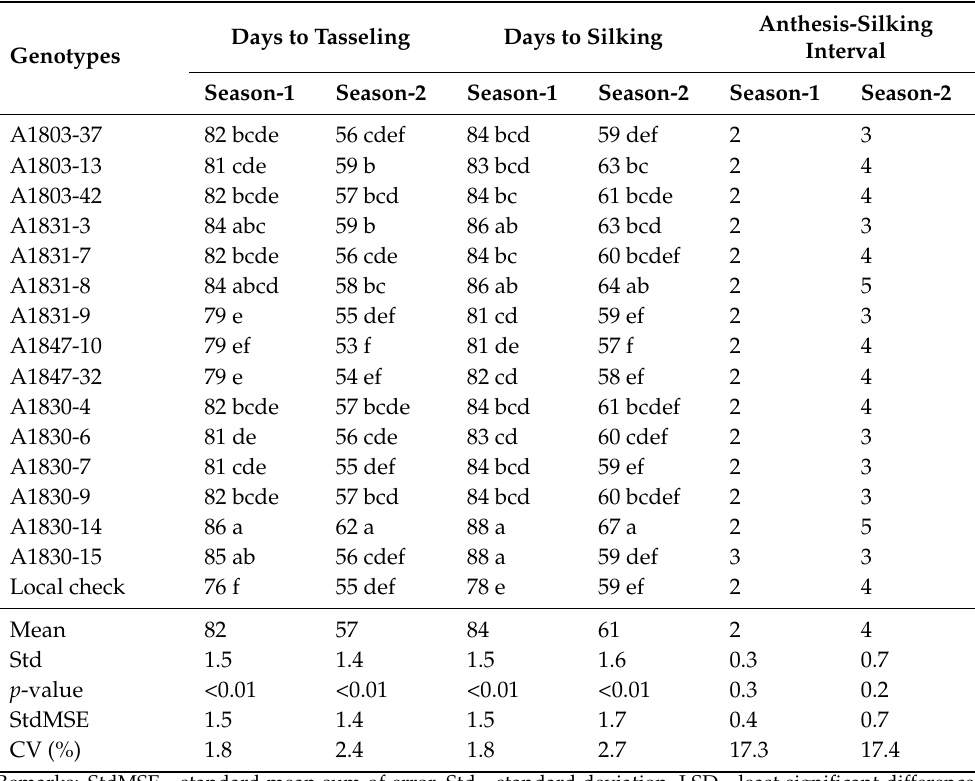
Table 3. Phenological traits of three-way cross zinc biofortified maize genotypes recorded from two contrasting